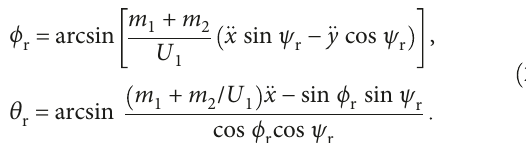
Figure 11: Attitude of the